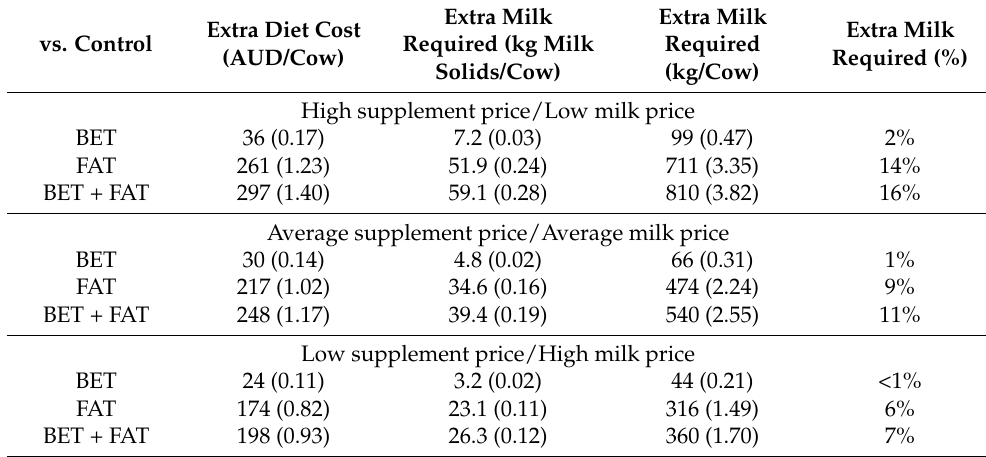
Table 2. Pre-experimental economic threshold analysis. Extra diet cost (AUD/cow), and extra milk required (kg milk solids/cow) over 212 days for the BET, FAT, and BET + FAT diets to be equally as profitable as the control diet, at a range of feed and milk prices and allowing for an 8% p.a. real opportunity cost. Per day figures are given in parentheses. The average percentage change in production was calculated assuming cows averaged 1.7 kg milk solids/day (23 kg milk/day) for 212 days when fed the control